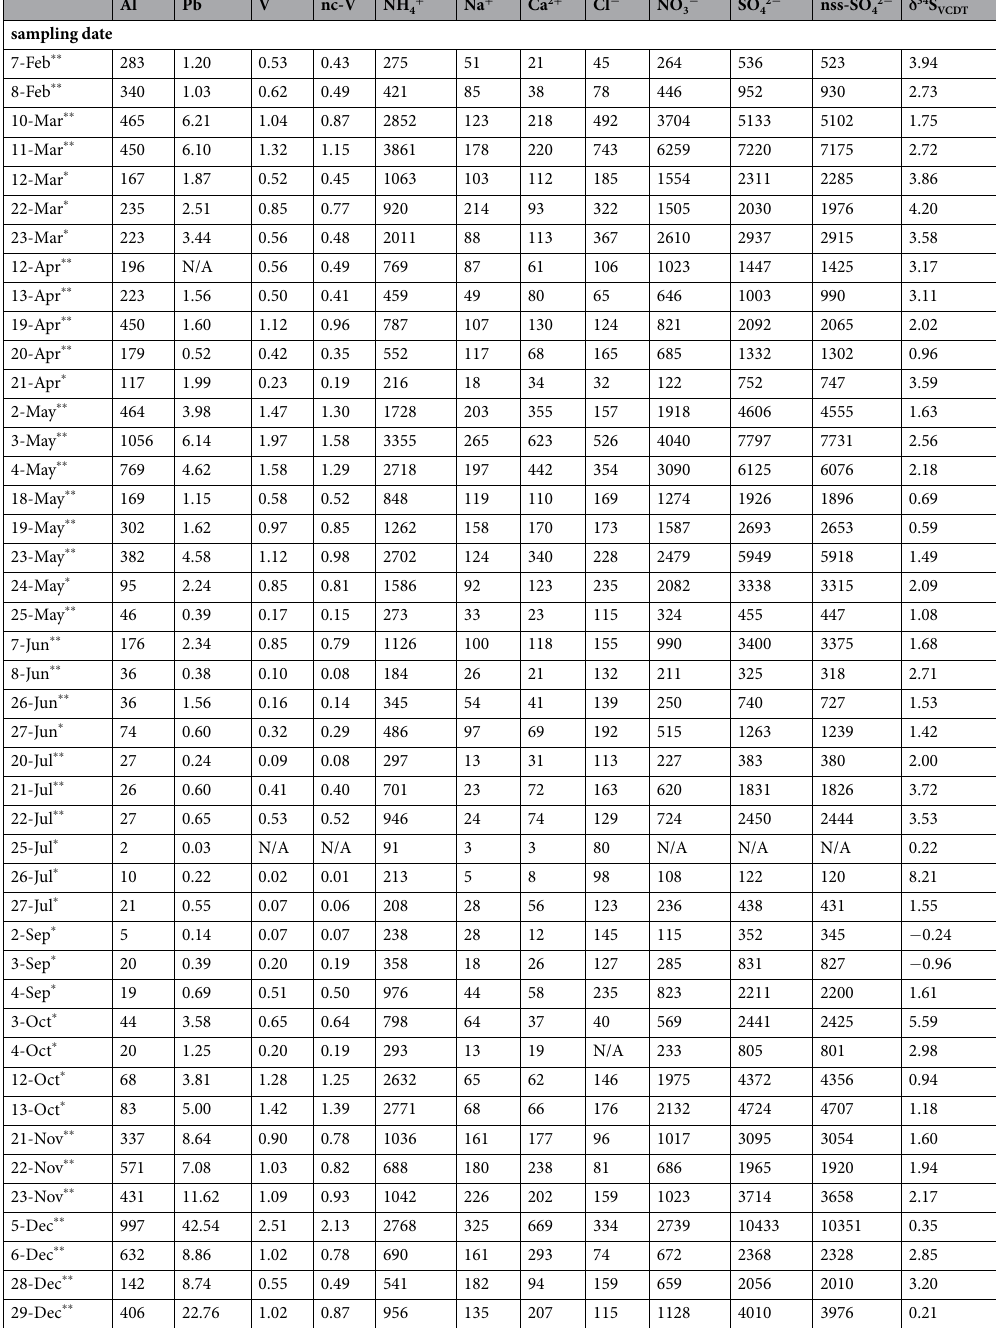
Table 2. Summary of the concentrations (in ng/m 3 ) and δ 34 S (in ‰) of sulfate for the 44 selected samples. Ions and metals relevant to the work are also shown. The superscripts * and ** refer to the source regions (based on five-day back trajectory) below and above the sampling location at Lulin. nc-V stands for non-crustal vanadium. See text for